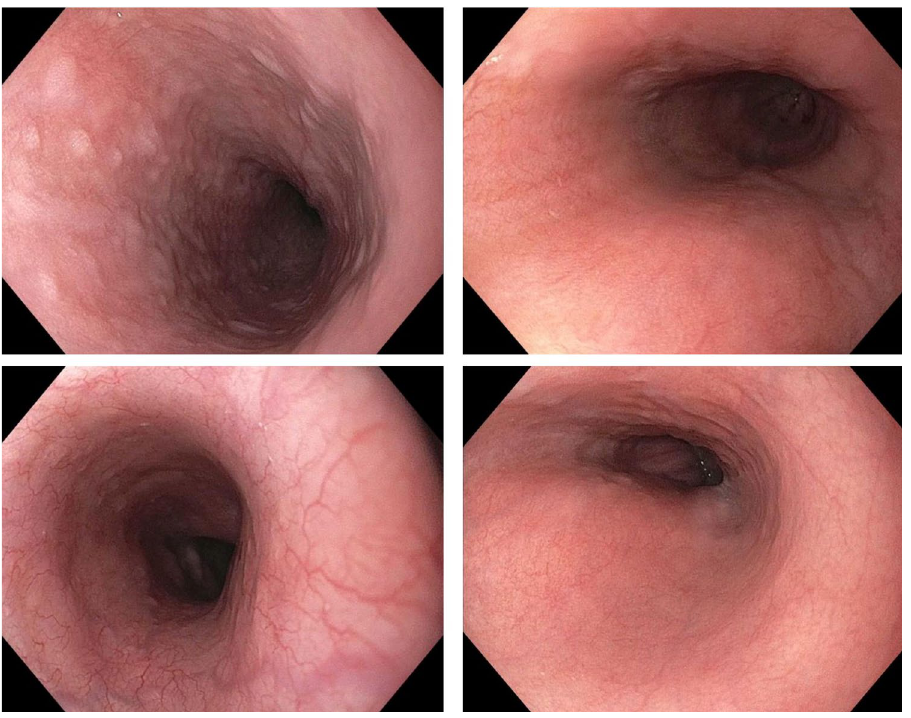
Figure 2. Endoscopic white light images of a normal